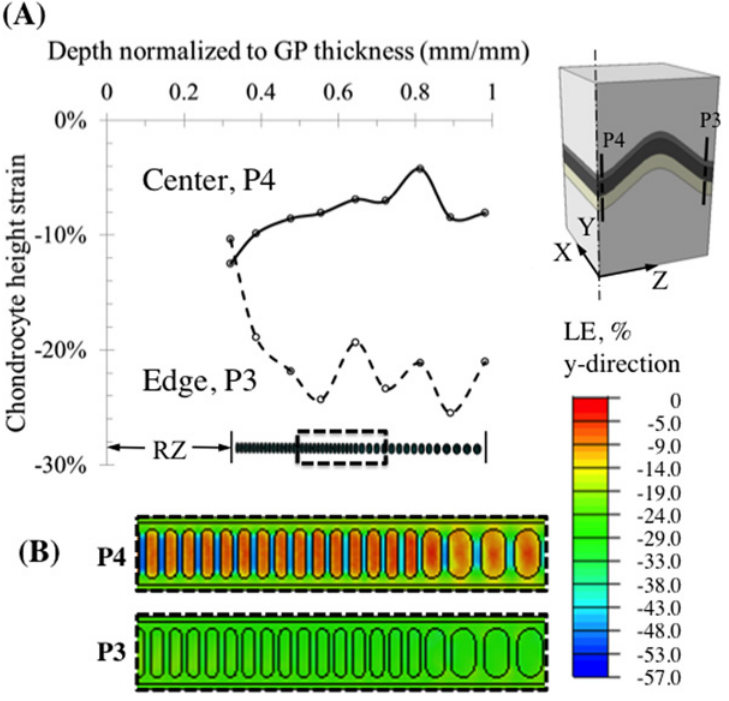
Fig 8. Chondrocyte deformation measured as change in cell height at two locations in the chondron for an overall axial compressive strain of 20%. (A) Cellular strains vary differently within each chondron depending on the location of the chondron. Within interior chondrons compressive axial cell strains peaked at the transition from reserve to proliferative zone where cell division occurs. Chondrons located close to the free surface (300 μ m from the surface) of the growth plate experienced a reverse strain pattern with peak compressive strains occurring in the hypertrophic zone where no cell division occurs, but where cell size increases 10-fold. (B) Contour plot of the logarithmic strain (LE) at the chondron scale in the y-direction at two locations, at the center (P4) and at 300 μ m from the edge (P3). The contour plot is obtained by extrapolating the integration point values to the nodes and then averaging.